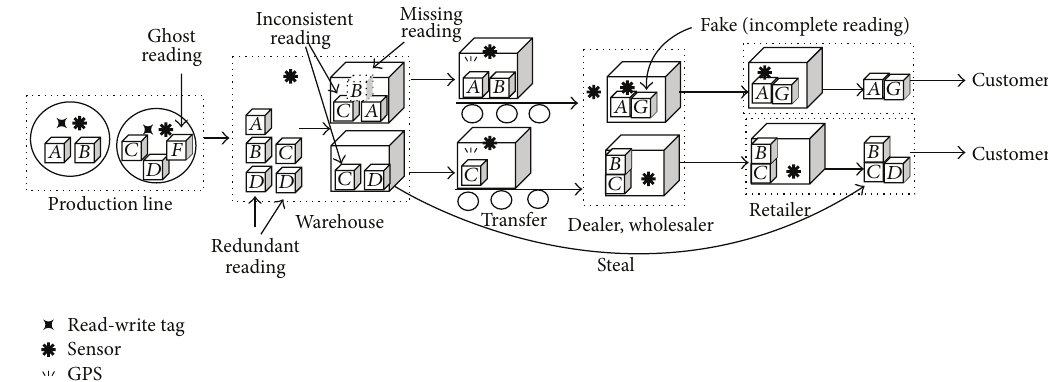
Figure 1: A RFID-based supply